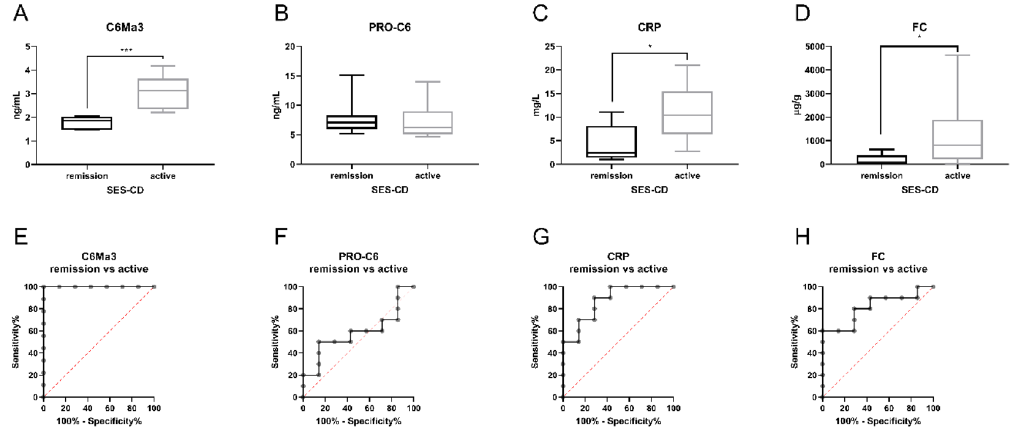
Figure 3. Levels and respective ROC-curves of the biomarkers C6Ma3 ( A , E ), PRO-C6 ( B , F ), CRP ( C , G ), and FC ( D , H ) in CD patients grouped in endoscopically remission (SES-CD ≤ 2) or active (SES-CD > 2). Unpaired tests and Mann Whitney test were used to test for difference in biomarker levels. *p < 0.05, ***p <